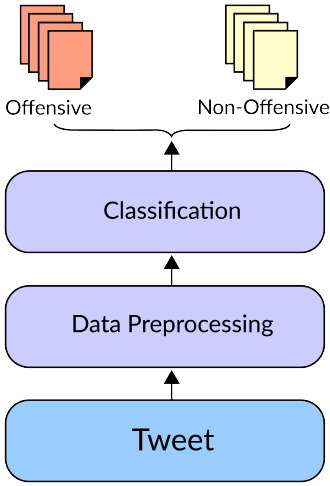
Figure 1. The general framework of deep learning